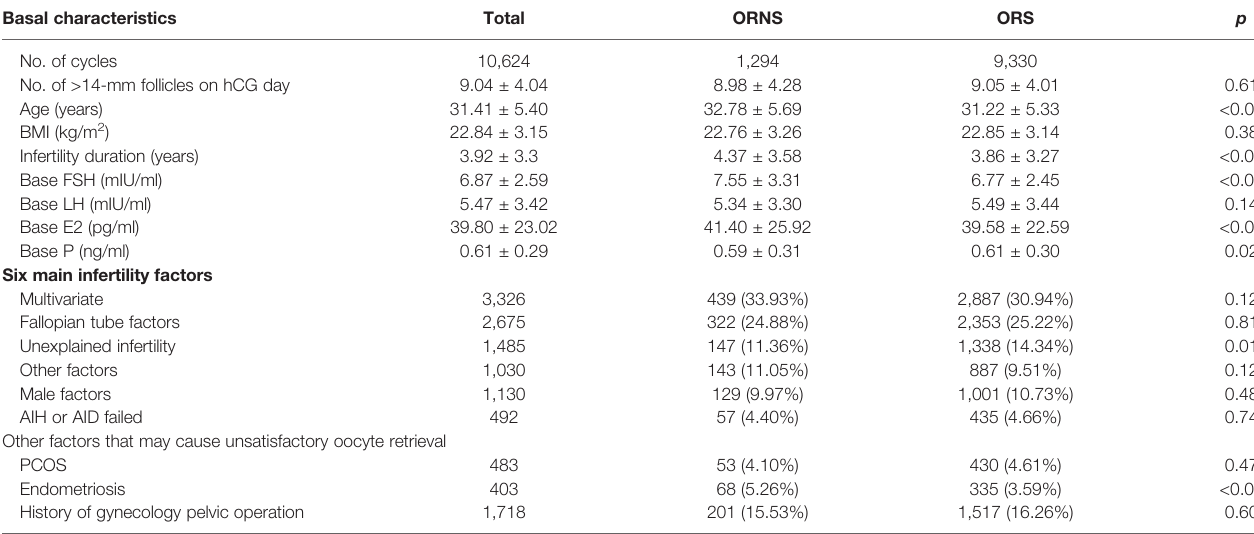
TABLE 1 | Demographic and clinical characteristics of the study population. Basal